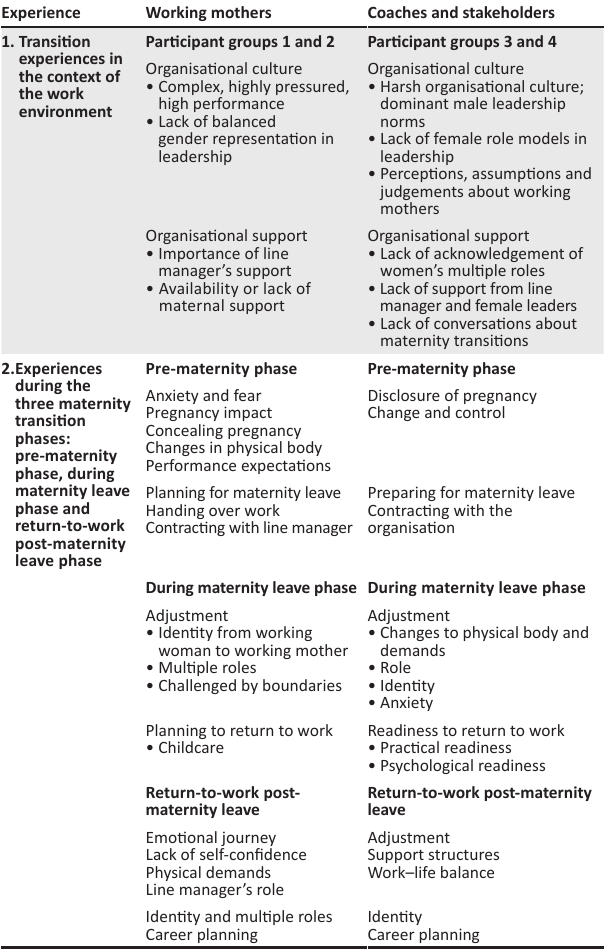
TABLE 3: Understanding the maternity transition experience: the ‘why’ of maternity coaching.